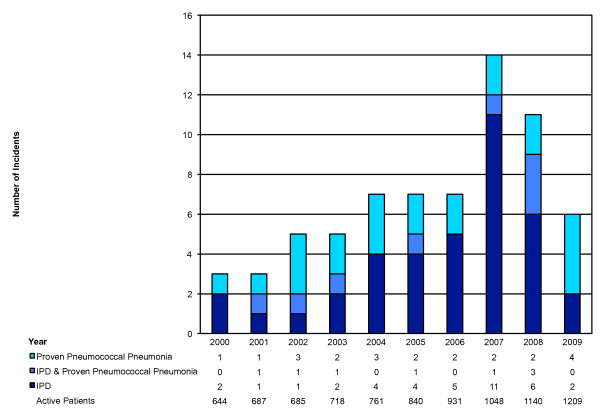
Number and type of pneumococcal infections per year. Pneumococcal disease in Southern Alberta HIV patients over 10 years; there is no evidence of a decreasing trend. The peak in 2007 overlaps with a serotype 5 outbreak among Calgary's homeless community [10]; number of active patients at the midpoint of each year.